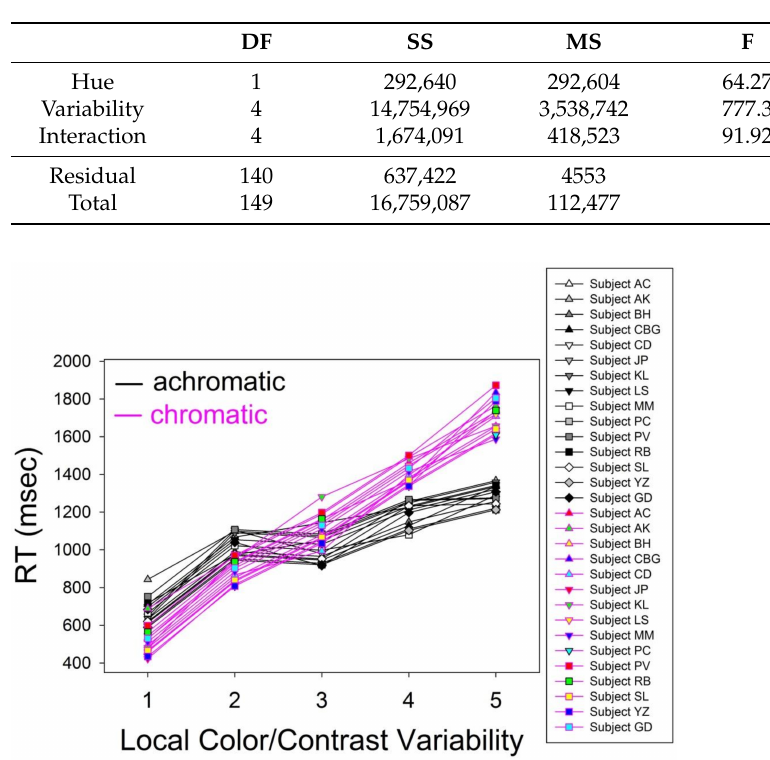
Table 4. Results from the two-way analysis of variance. Degrees of Freedom (DF), Sums of Squares (SS), the corresponding F statistic, and the associated probability limit ( p ) for each of the two factors and their interaction.